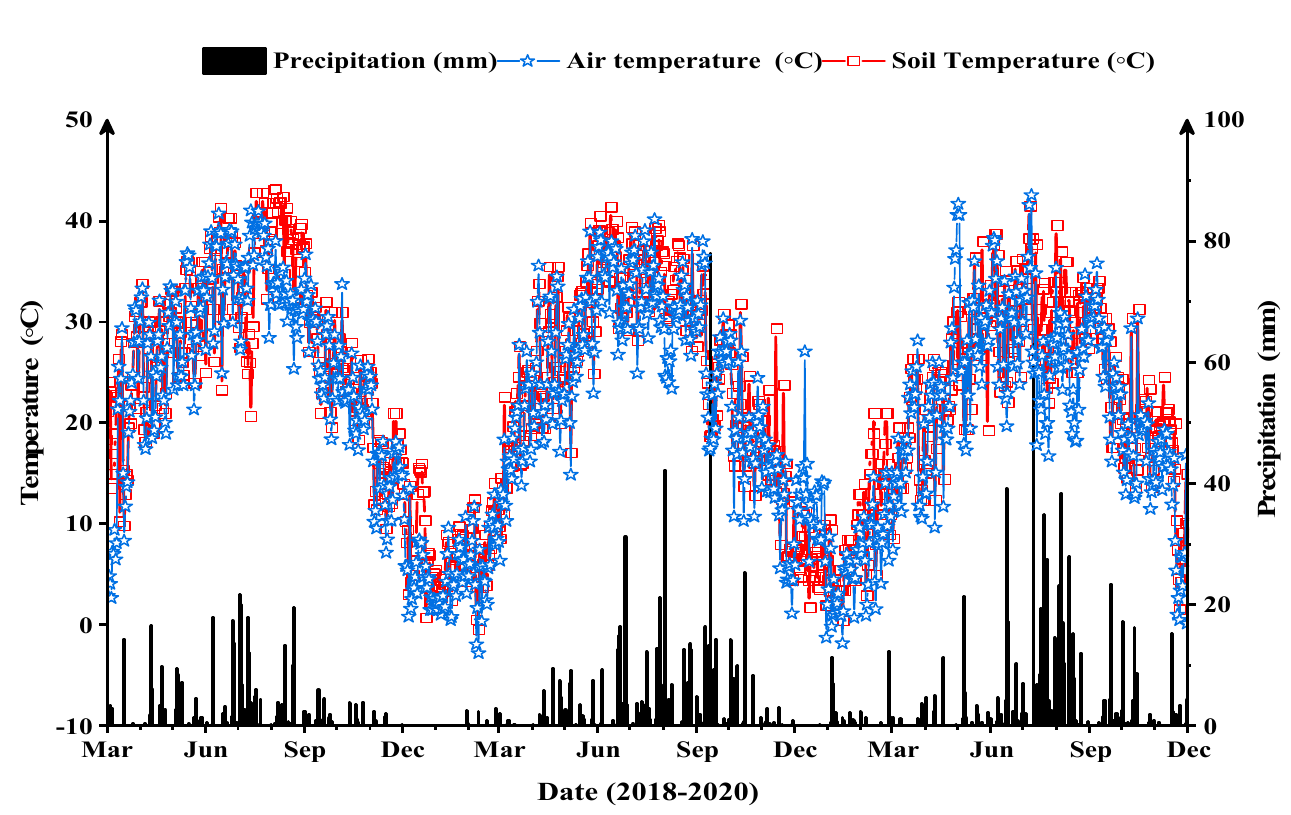
Figure 2. Seasonal dynamics of precipitation (mm) and soil temperature. Blue: air temperature, red: soil temperature (20 cm depth, °C) in the studied apple orchard from 2018 to 2020.